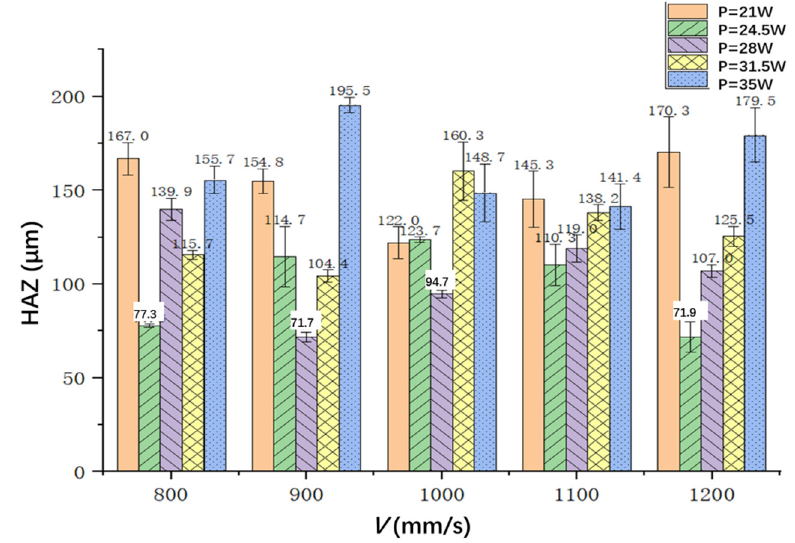
Figure 7. The HAZ with different laser powers and scanning speeds.